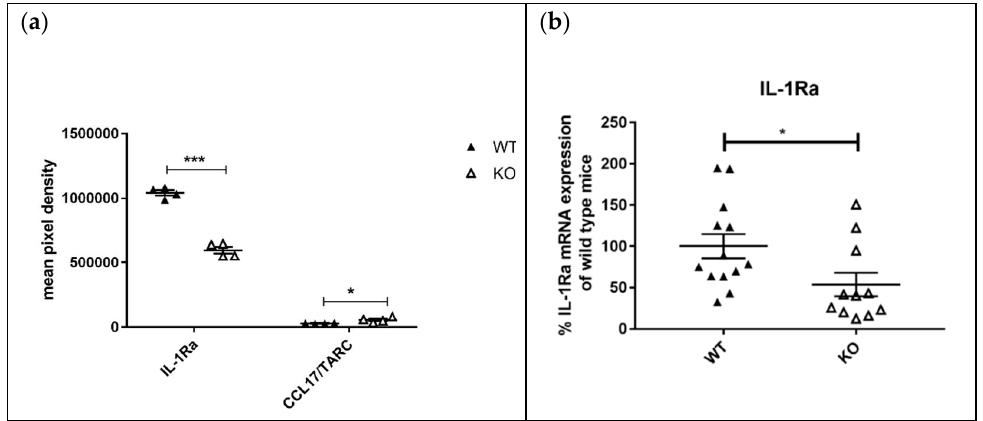
Figure 6. Analysis of chemokine and cytokine expression in the kidneys of MRL-Fas lpr KSRP − / − mice ( a ) For the “mouse cytokine array” proteome profile analyses, proteins were isolated from the kidneys of MRL-Fas lpr KSRP − / − mice (KO) compared to MRL-Fas lpr KSRP +/+ mice (three animals per group). The data show quantitative protein analyses of genotype-specific regulated cytokines and chemokines. All data (means ± SEM) show the absolute protein expression compared to MRL-Fas lpr KSRP +/+ mice (*** p < 0.001, *: p < 0.05 compared to WT, t -test, n = 3). ( b ) RNA was isolated from the kidneys of 19-week-old female MRL-Fas lpr KSRP − / − mice (KO) and MRL-Fas lpr KSRP +/+ mice (WT). IL-1RA mRNA expression was analyzed by qRT-PCR and normalized to the mRNA expression of Tata-Box-Binding Protein (TBP). Data presented are the mean ± SEM of the relative mRNA expressions based on WT female 19 weeks (100%) 12 animals per genotype (*: p < 0.05; compared to WT 19 weeks, t -test).